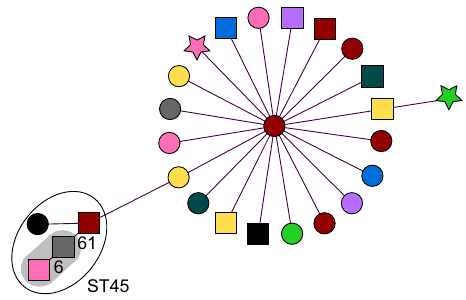
Fig. 3 Minimum spanning tree of whole genome multilocus sequence typing results of 26 K. pneumoniae isolates. Circles/squares/stars represent one isolate, which is connected to the closest relative. The circles represent colistin-susceptible isolates, the squares colistin-resistant isolates and the stars colistin-resistant isolates with mcr genes. The length of the lines in between the isolates is proportional to the allelic distance. For clusters, the allelic differences between the isolates are denoted. Groups of isolates with the same classical MLSTsequencetypeareindicatedinthe fi gure(ST45).Thecoloursrepresentthe different participating medical microbiology laboratories. A cluster is indicated by a grey halo and is de fi ned as ≥ 2 isolates with an allelic difference of ≤ 20. Source data: Supplementary Data fi les 2 and 3 and the Sequence Read Archive of the National Centre for Biotechnology Information (BioProject ID